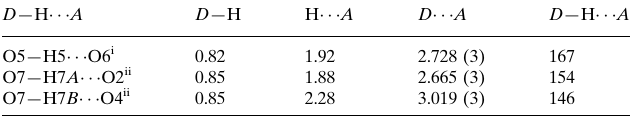
Hydrogen-bond geometry (A˚ , (cid:2)